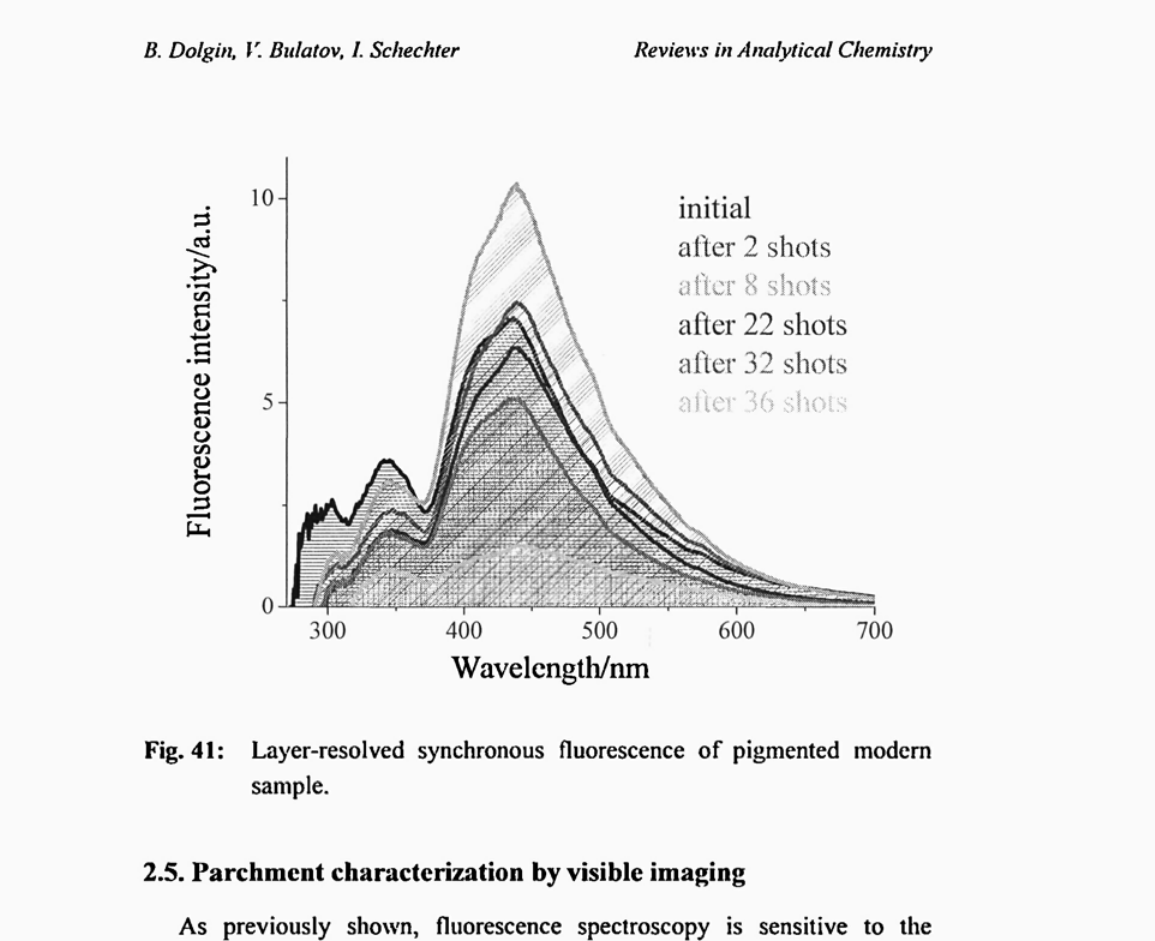
Fig. 41: Layer-resolved synchronous fluorescence of pigmented modern